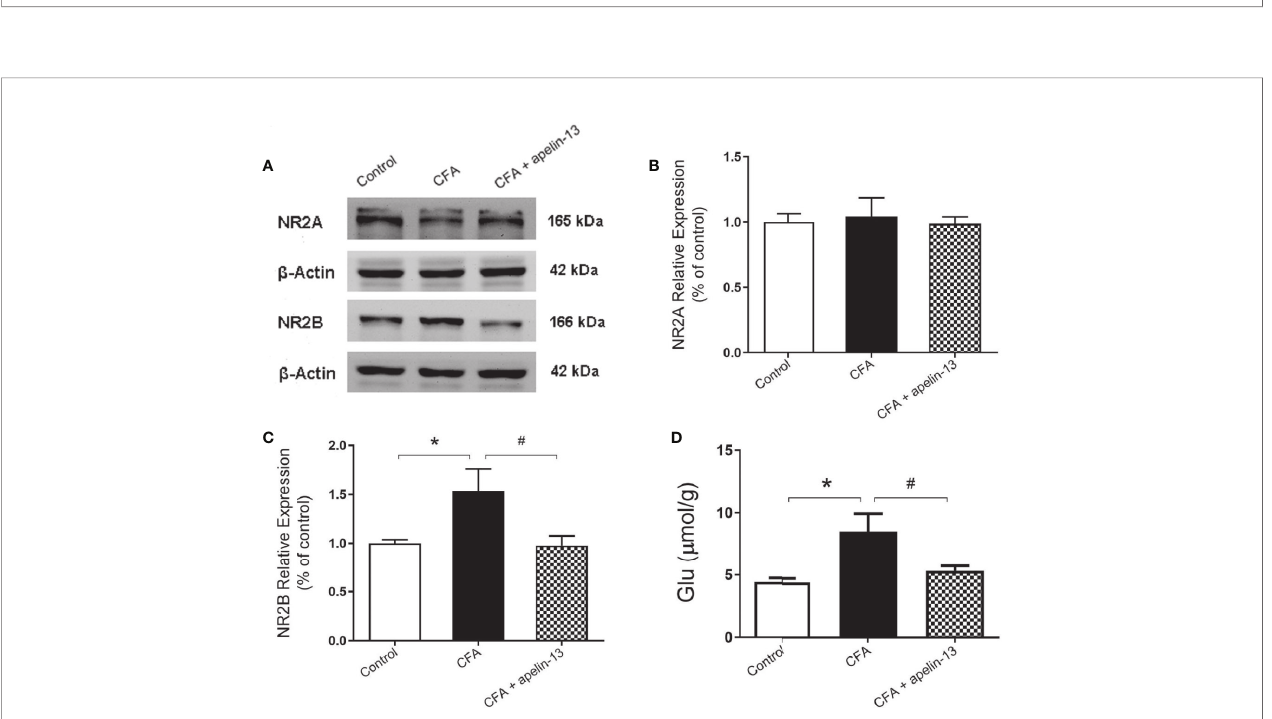
FIGURE 4 | Effect of i.t. apelin-13 on NR2A and NR2B expression, and Glu concentration in mice. (A) Expression of NR2A and NR2B in the mouse L4/5 spinal cord determined by western blotting. b -Actin was used as a loading control. (B, C) Quantitative analysis of normalized optical density (NR2A/ b -actin, NR2B/ b -actin) in the three groups. (D) Concentration of Glu in the mouse L4/5 spinal cord detected by HPLC. Data are expressed as means ± SEM. n = 4 – 6 per group. * p < 0.05, compared with vehicle control (i.d. NS + i.t. NS); # p < 0.05, compared with CFA group (i.d. CFA + i.t.